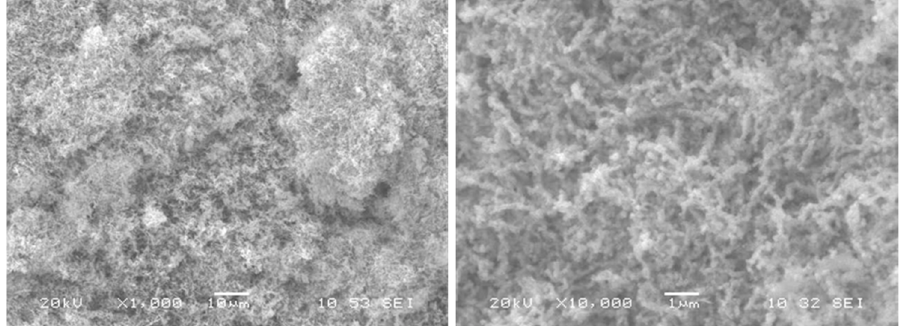
Figure 2. SEM pictures of NiO powder .